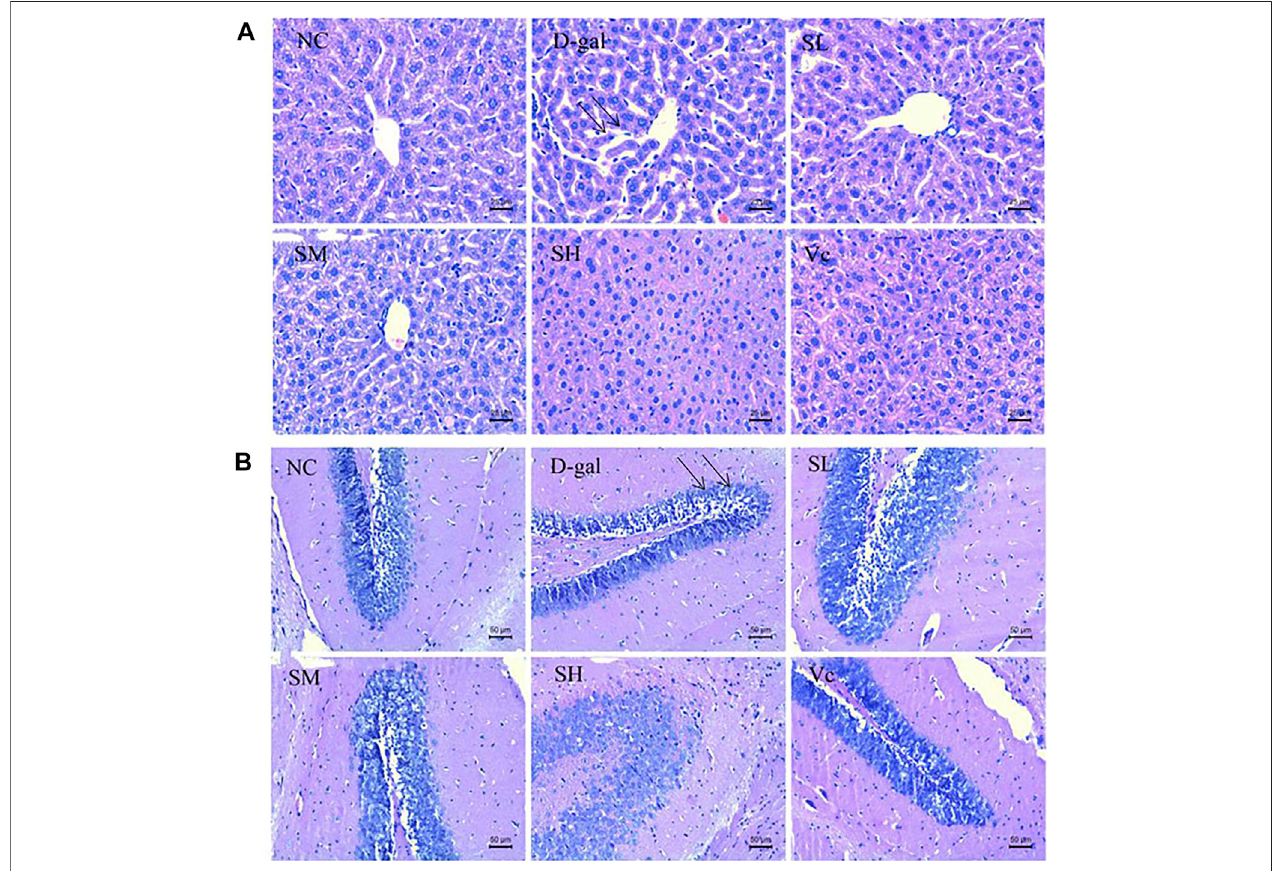
FIGURE2| Histopathologicalchangesofliver (A) andbrain (B) inmice( × 400).NC:normalcontrolgroup;D – gal:D – galmodelgroup;SL:low – doseSDEgroup;SM: medium – dose SDE group; SL: high – dose SDE group; Vc: Vc positive control group. The arrow indicates the injury site.